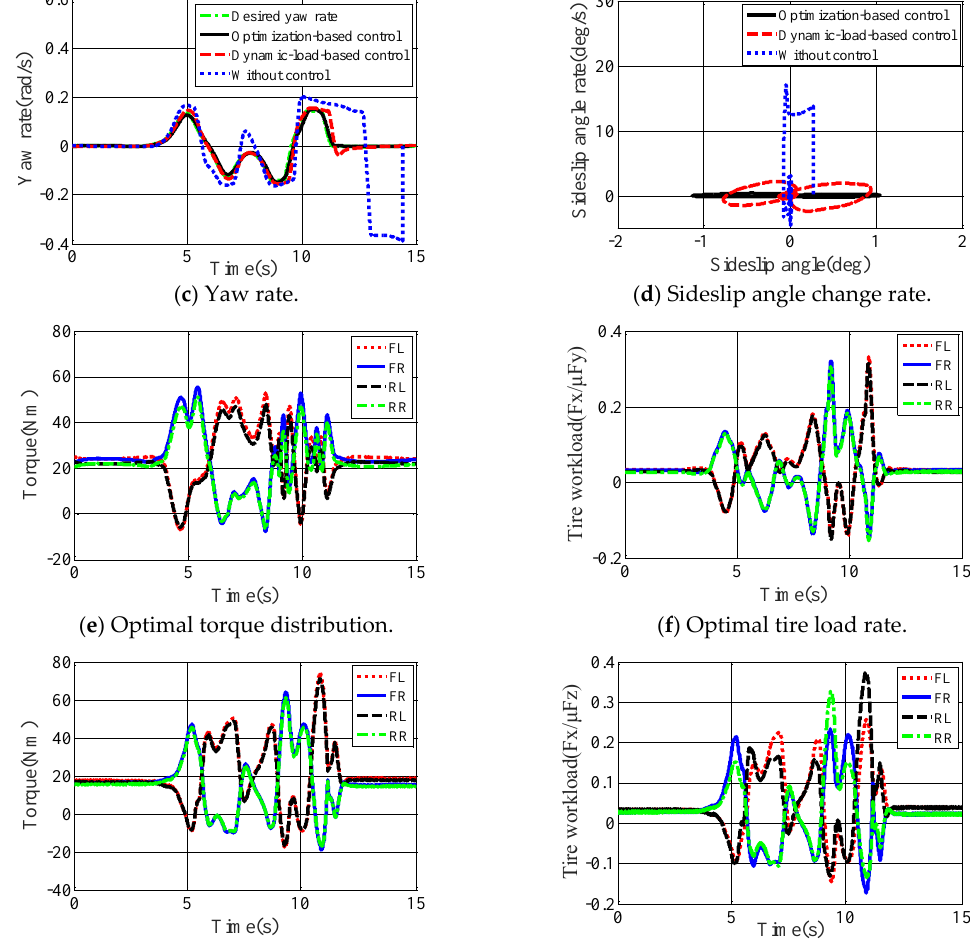
Figure 9. Simulation results for double lane change with low friction.